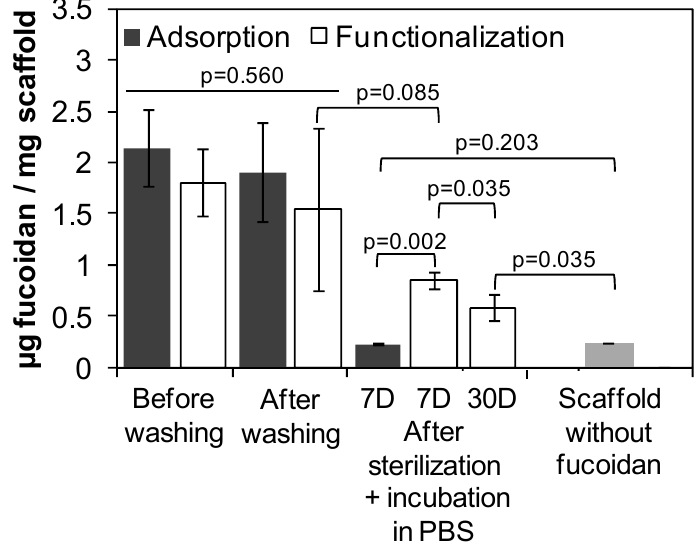
Figure 4. Amount of LMW fucoidan immobilized inside sca ff olds when adsorbed after the sca ff old elaboration (adsorption), or when directly incorporated during the sca ff old elaboration (functionalization) before washing, after washing and after incubation in PBS by comparison with sca ff olds synthesized in the absence of fucoidan. (The LMW fucoidan concentration in the aqueous phase used for adsorption or functionalization = 10 mg mL − 1 ).